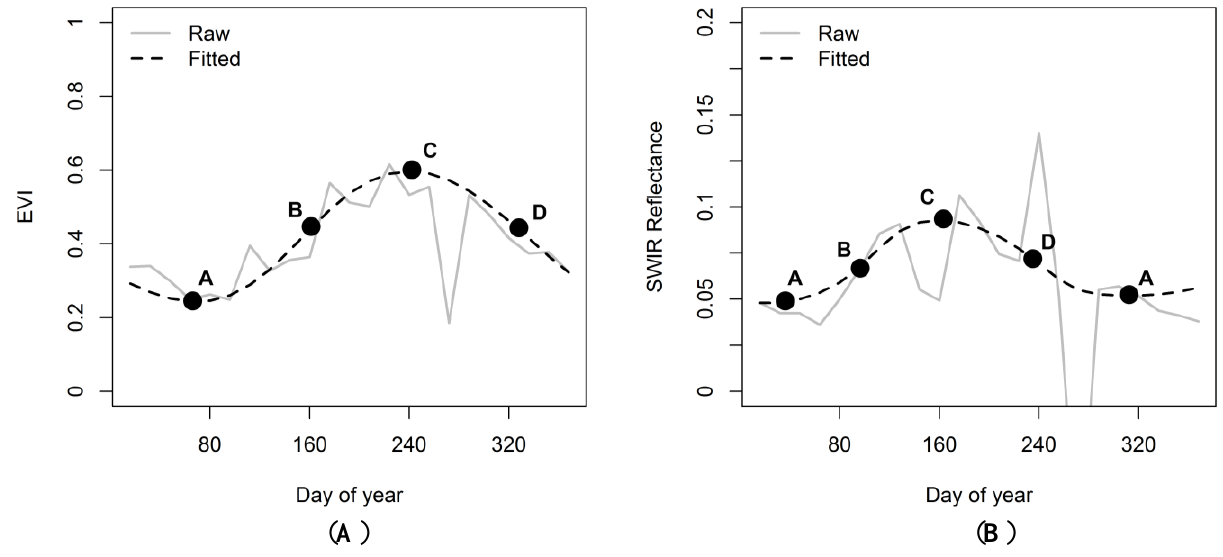
Figure 3. Raw and fitted Moderate Resolution Imaging Spectroradiometer